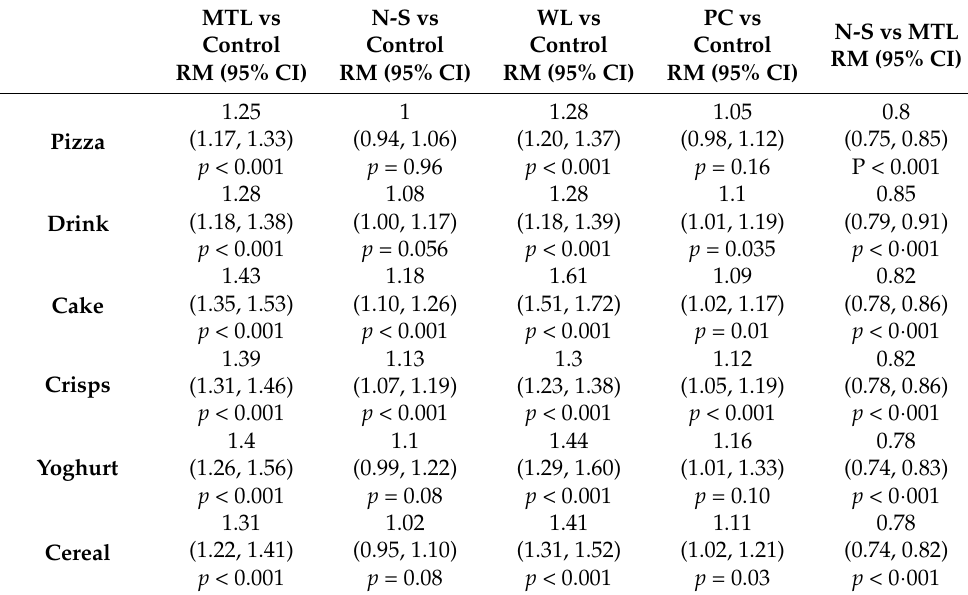
Table 5. Multiple regression analysis results—association between time taken to rank products at follow-up and FOPL group compared to control (adjusted for baseline ranking time, device used, design factors and